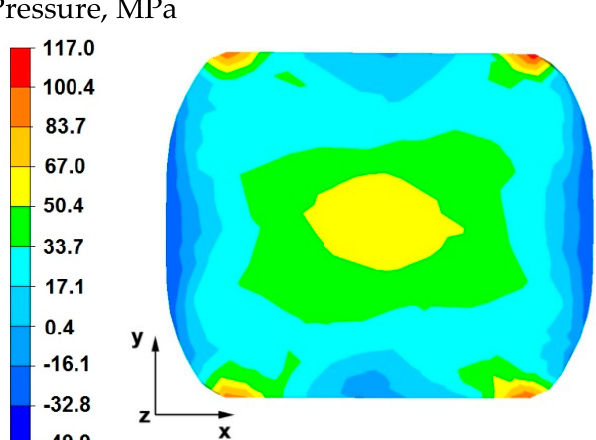
Figure 11. Distribution of hydrostatic pressure on the surface of the cross-section of the sample with modeled discontinuity after rotation by 90° and re-deformation with 35% reduction.